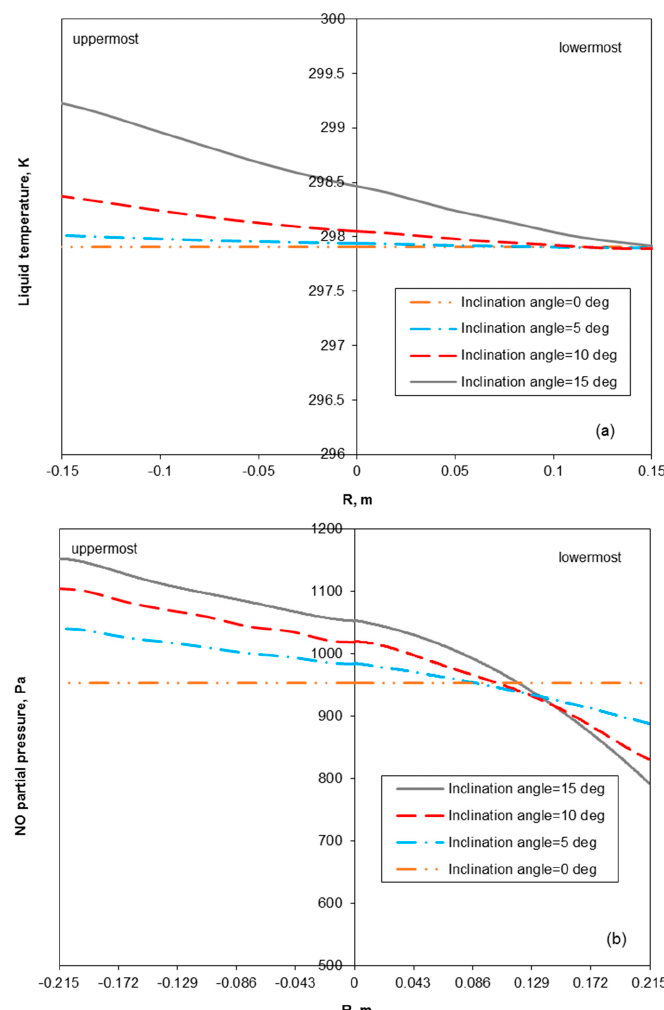
Figure 14. Steady-state radial profiles of liquid temperature ( a ) and NO partial pressure ( b ) in x-axis (see Figure 1)—vertical and inclined seawater scrubbers (Packed-bed column with Raschig super-Rings; H = 5 m; z/H = 0.8; Pressure = 2.5 MPa).